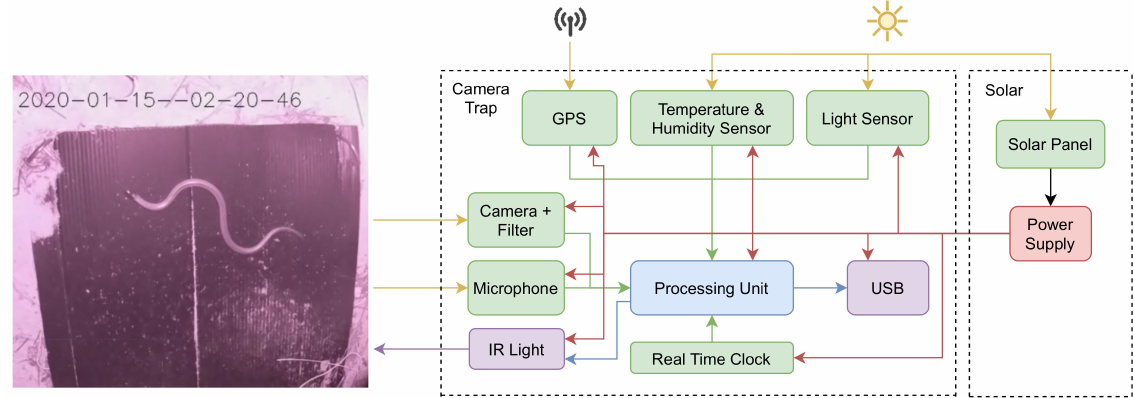
Figure 1. Hardware architecture of the camera trap.